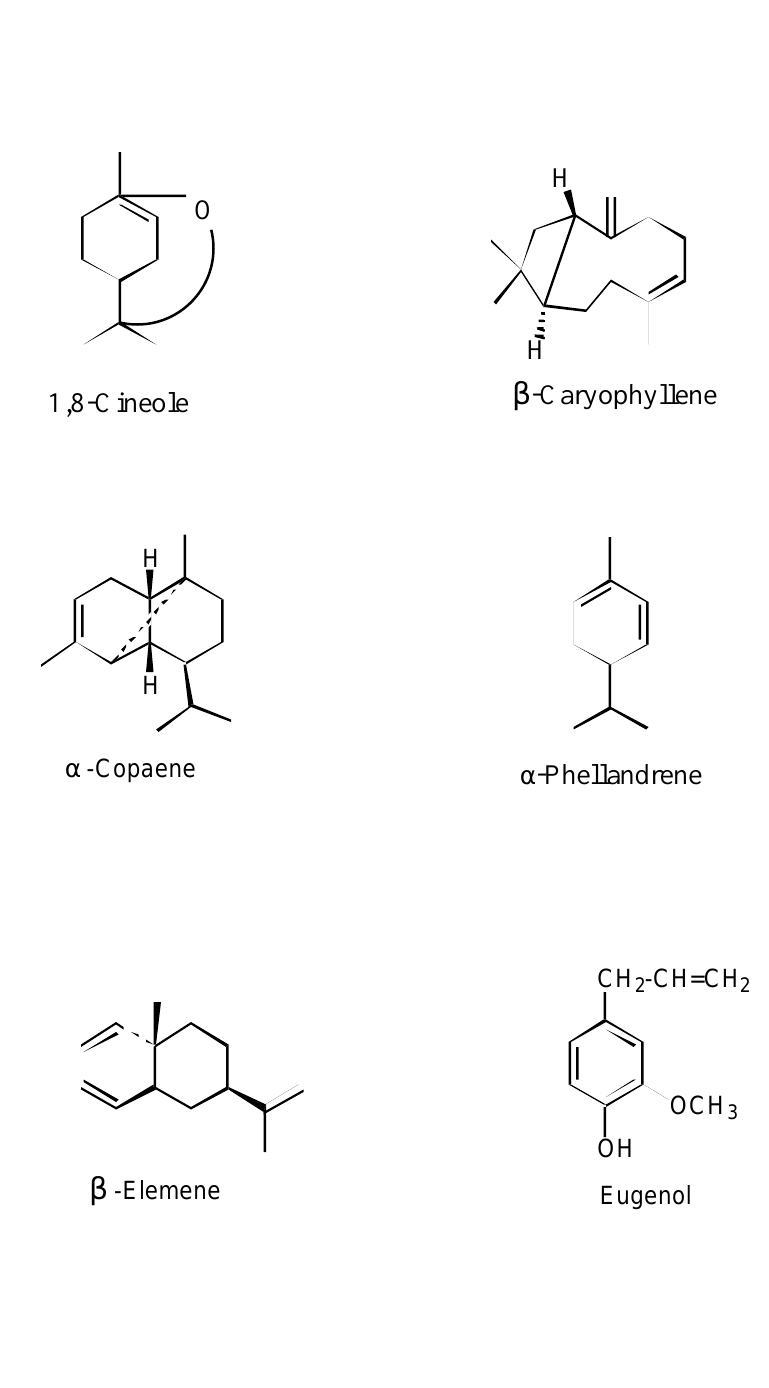
Fig. 1. Major components, 1,8- cineole and b -caryophyllene and others only found in Hyptis